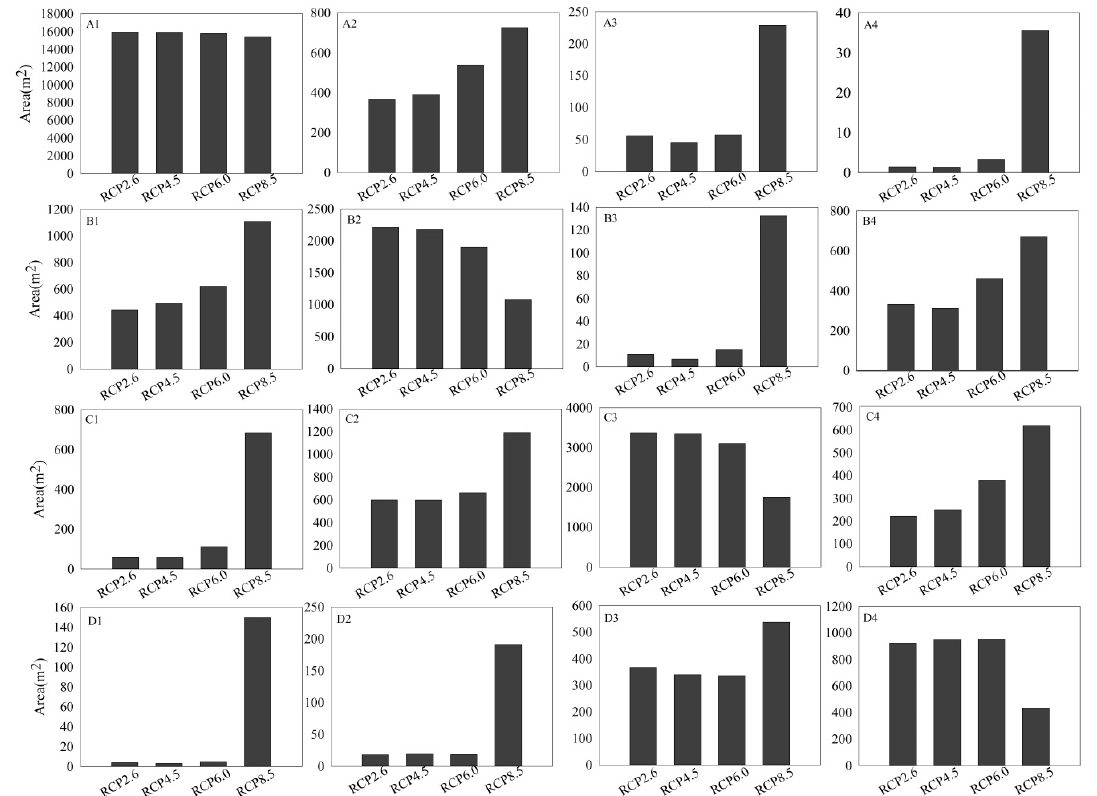
Figure 5. The transfer matrix of Qinghai spruce’ potential distribution area between current and